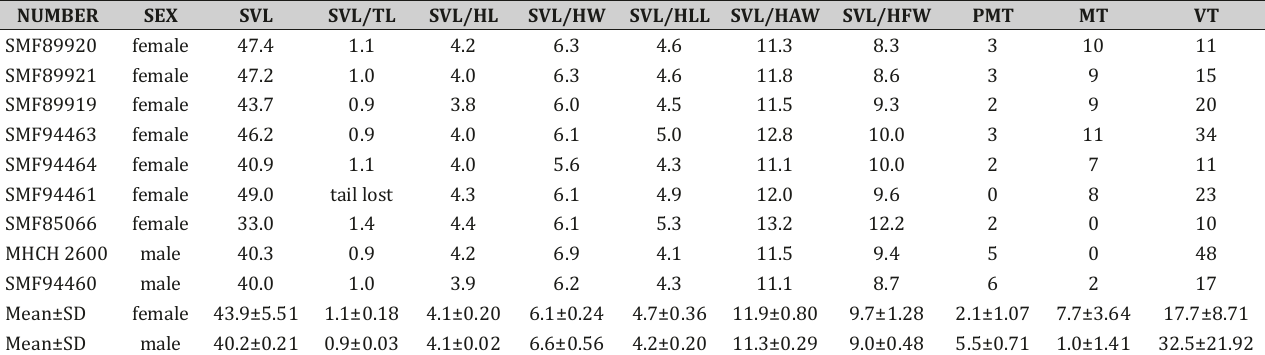
Bolitoglossa colonnea. Bolitoglossa schizodactyla